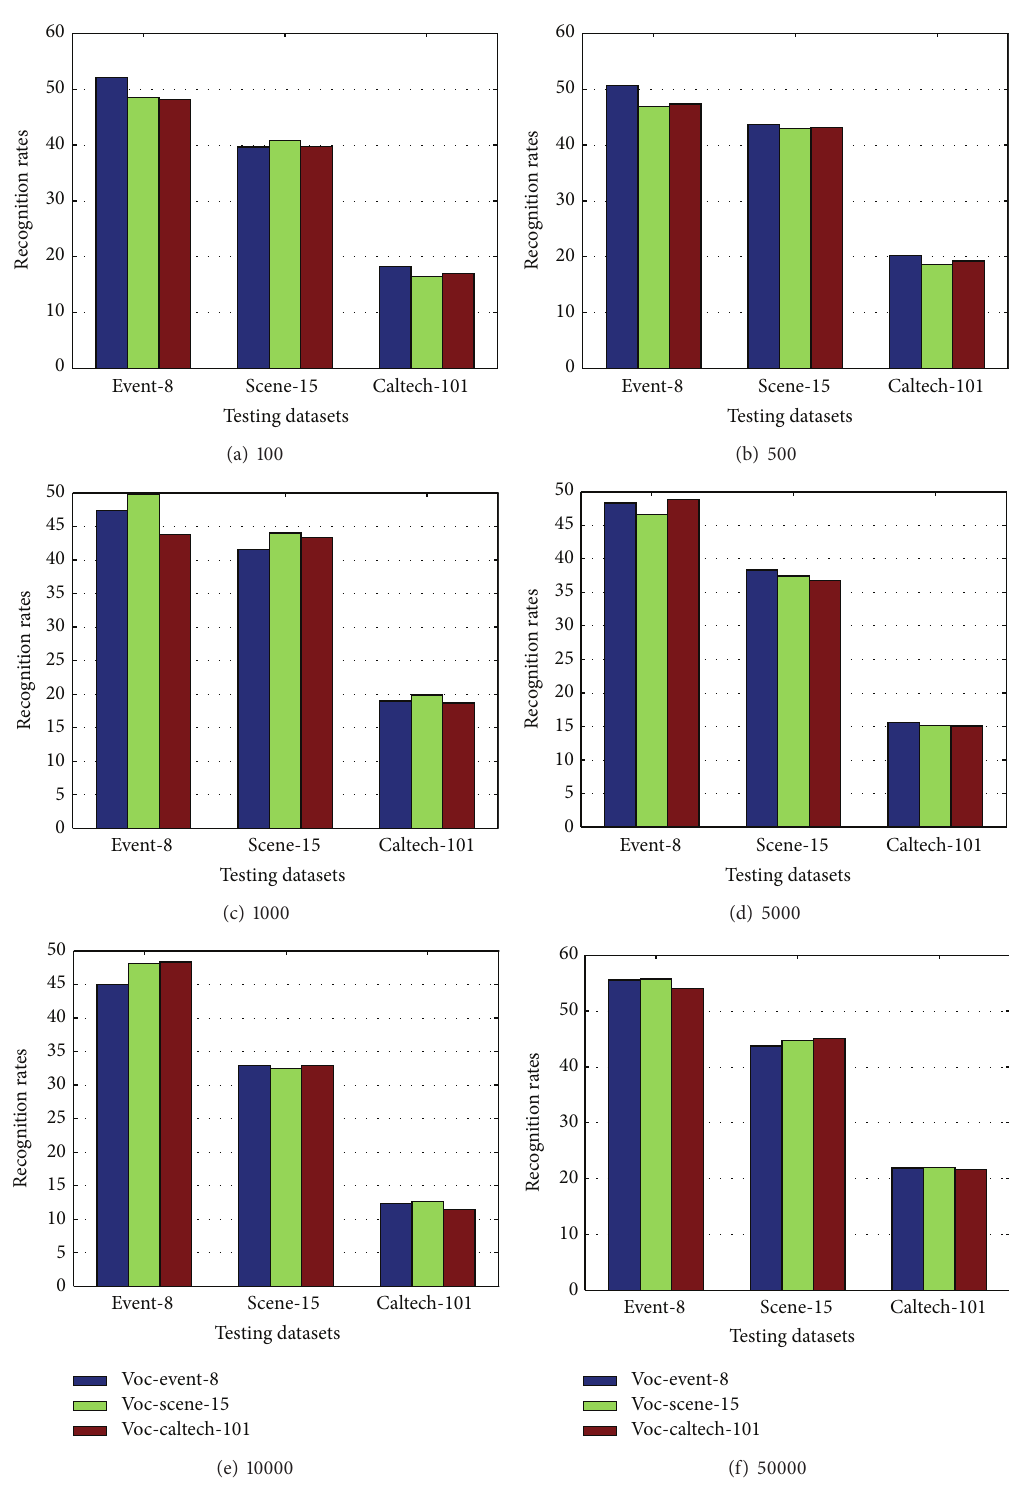
Figure 3: The relationship between universality of the algorithm and vocabulary sizes, with 𝑘 = 3